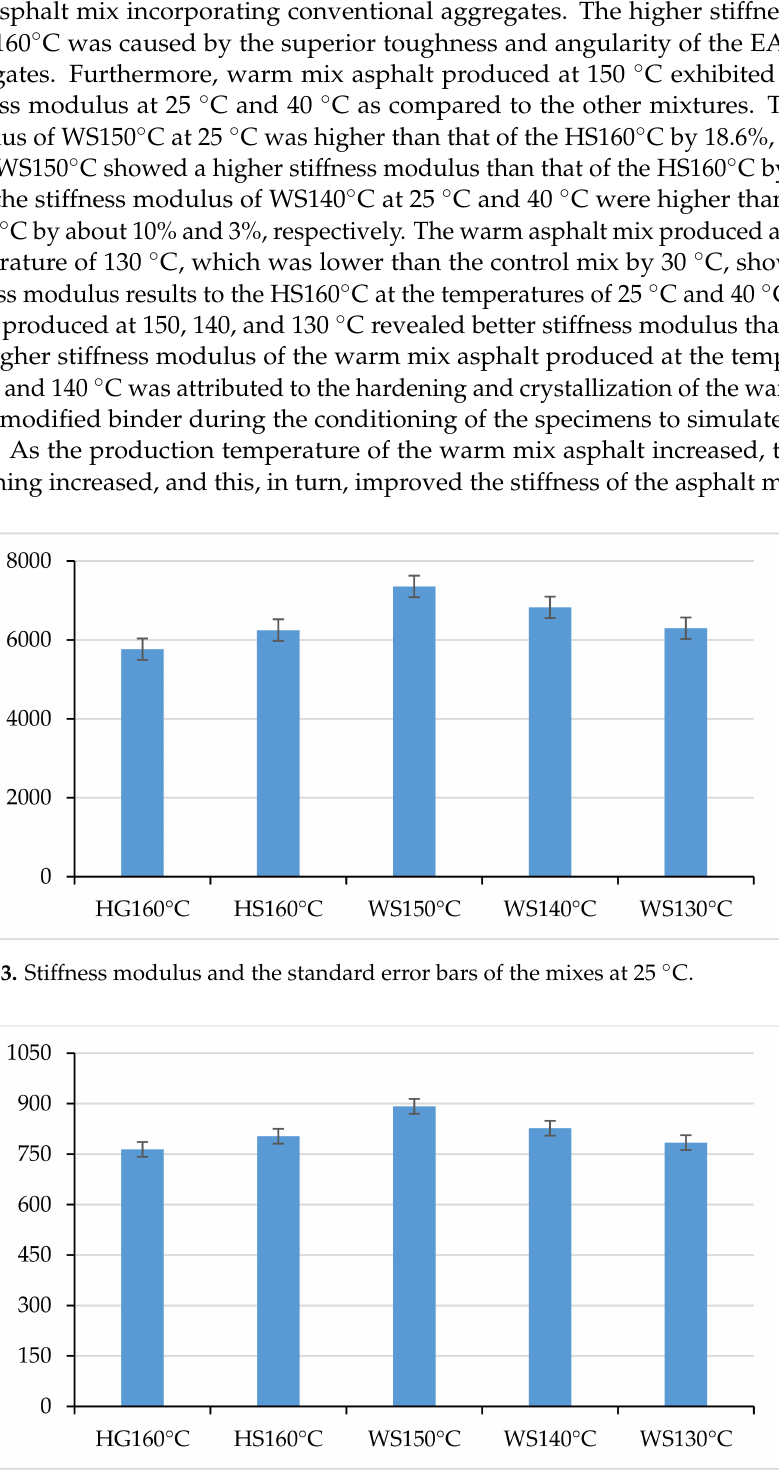
Figure 4. Stiffness modulus and the standard error bars of the mixes at 40 ◦